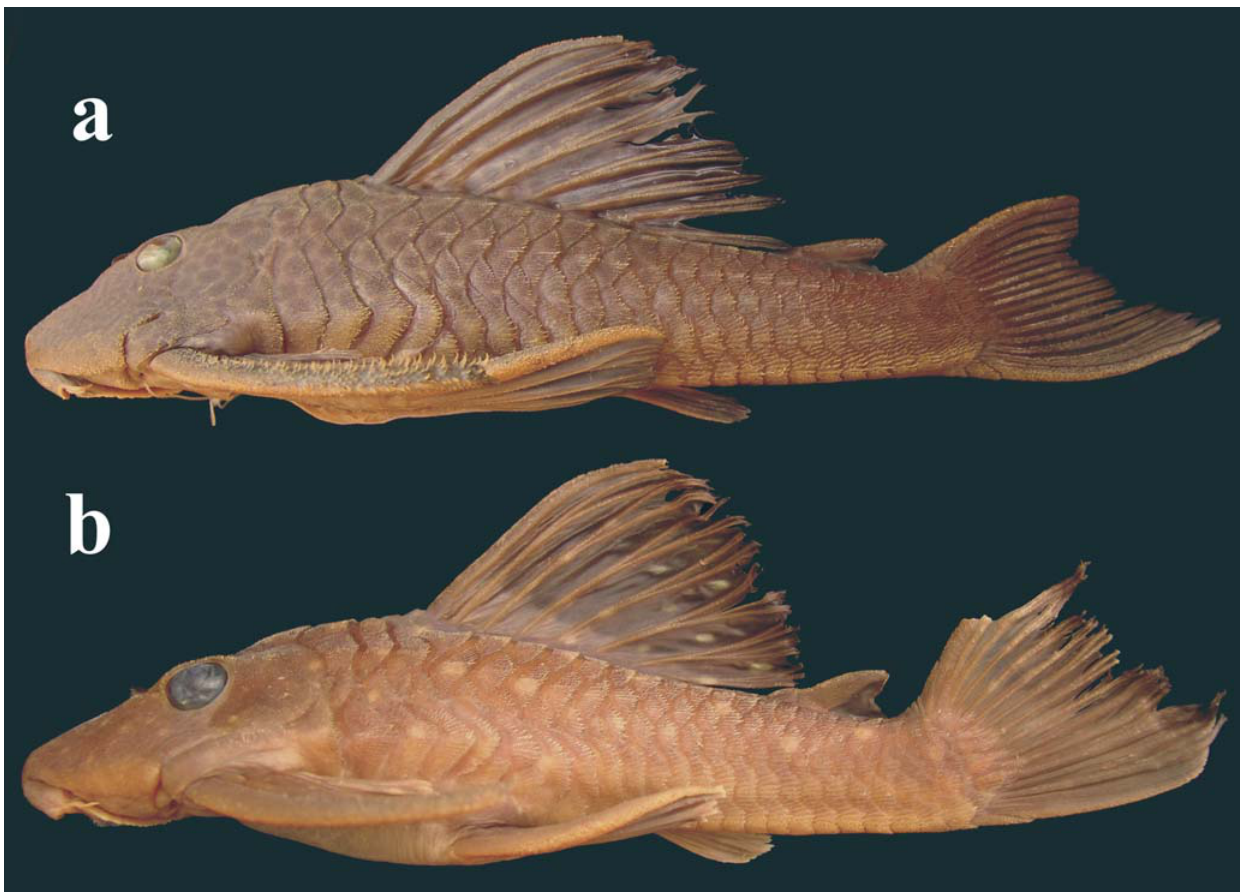
Fig. 3. a, Hypostomus denticulatus , paratype, NUP 4308, 194.3 mm SL, and b, H. multidens , NUP 5340, 157.0 mm